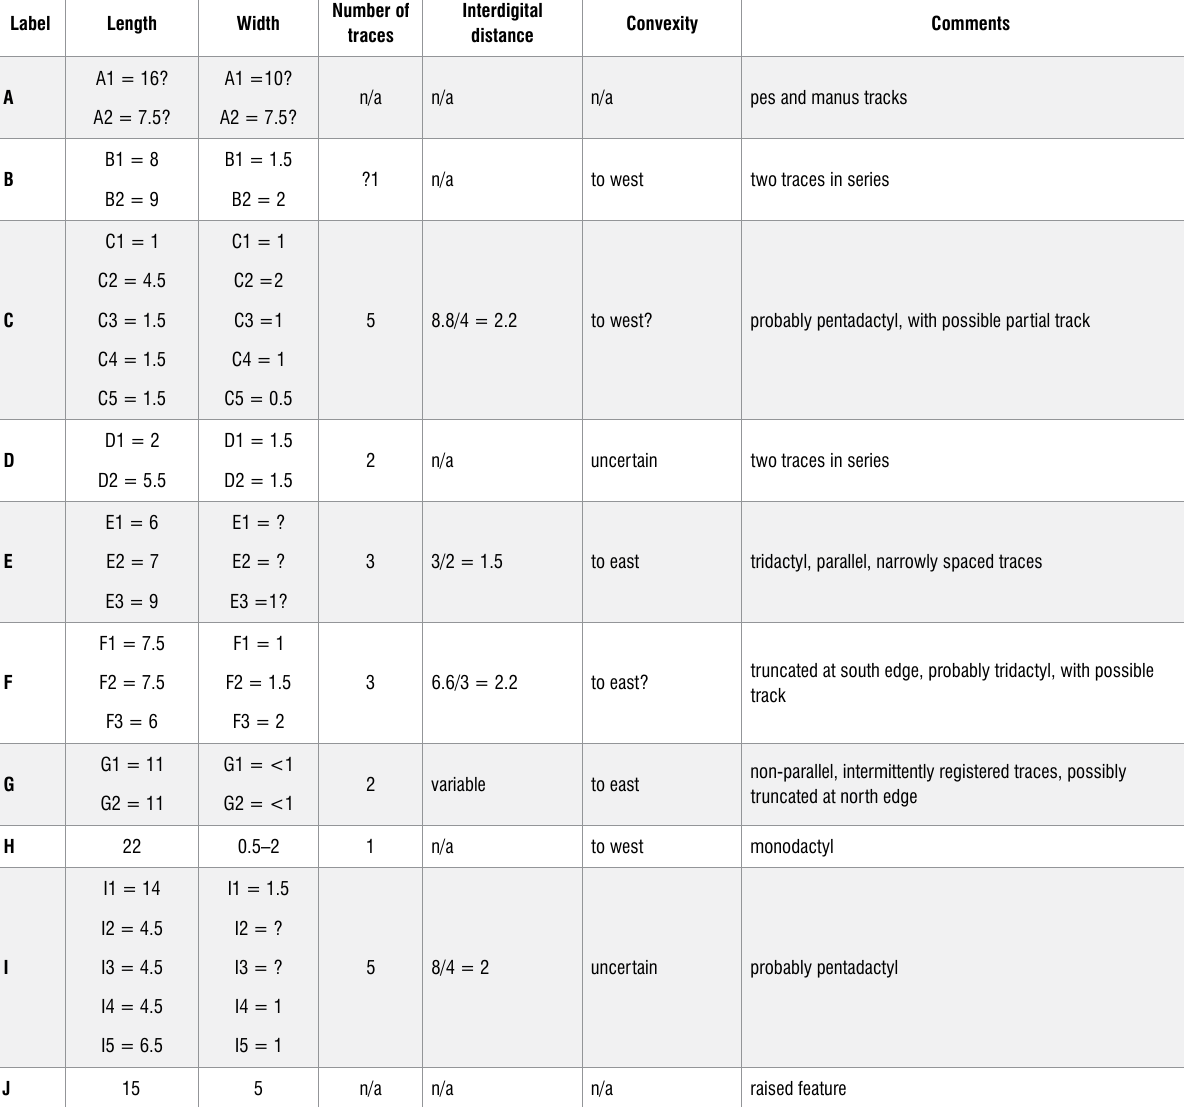
Table 1: Recorded measurements, in centimetres, on the surface containing tracks and traces Label